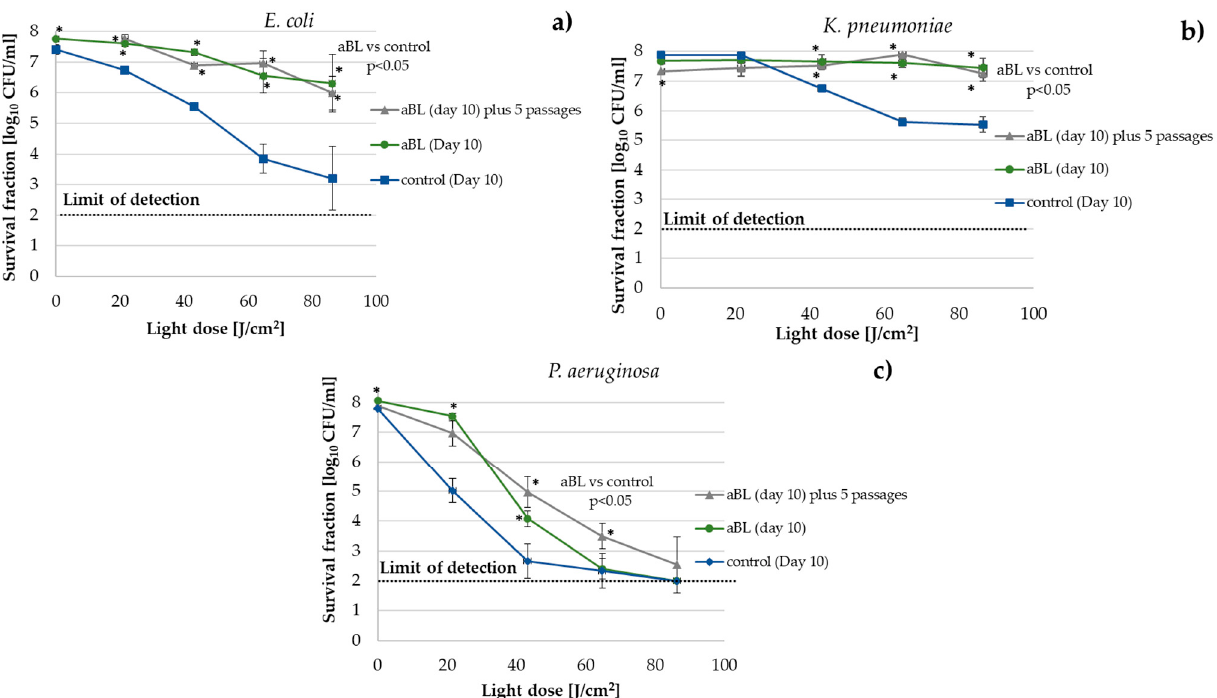
Figure 4. The phenotypic stability of the developed tolerance to aBL. The samples that originated from the 10th consecutive cycle of aBL treatment were transferred to 5 mL of fresh LB medium and cultured at 37 °C for 16–20 h. A total of 50-µL aliquots of the overnight cultures were transferred to tubes containing fresh LB medium. The cycle of transfer—regrowth—transfer was repeated five times. After five passage cycles, the cultures were diluted to an OD of 0.5 McF, and 100 µL of the bacterial suspensions were irradiated with 415 nm light at a dose up to 86.4 J/cm 2 for E. coli ( a ) , K. pneumoniae ( b ), and P. aeruginosa ( c ). The resulting suspensions were compared with the initial samples and with the untreated controls. The detection limit was 100 CFU/mL. The values are the means of three separate experiments. The error bars represent the standard deviation (SD). * All of the significant differences were estimated in comparison to the control (Day 10).